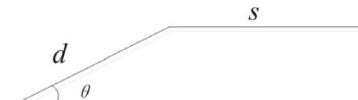
Figure 7 Crack path deflection diagram